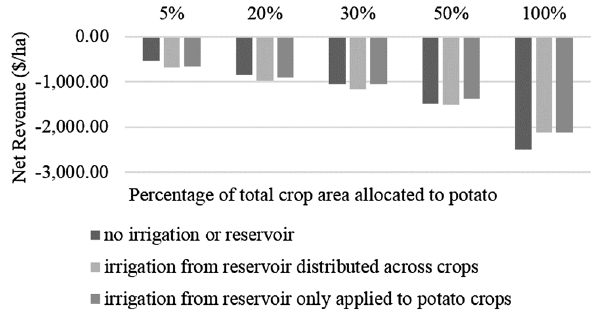
Fig. 7 Study area net revenue for 2006, simulating various irrigation application scenarios, using four crops (alfalfa, canola, wheat, and potato), and adjusting the percentage of crop area allocated to potato to determine its impact on net crop revenue. Costs associated with irrigation and reservoir infrastructure were accounted for when irrigation was